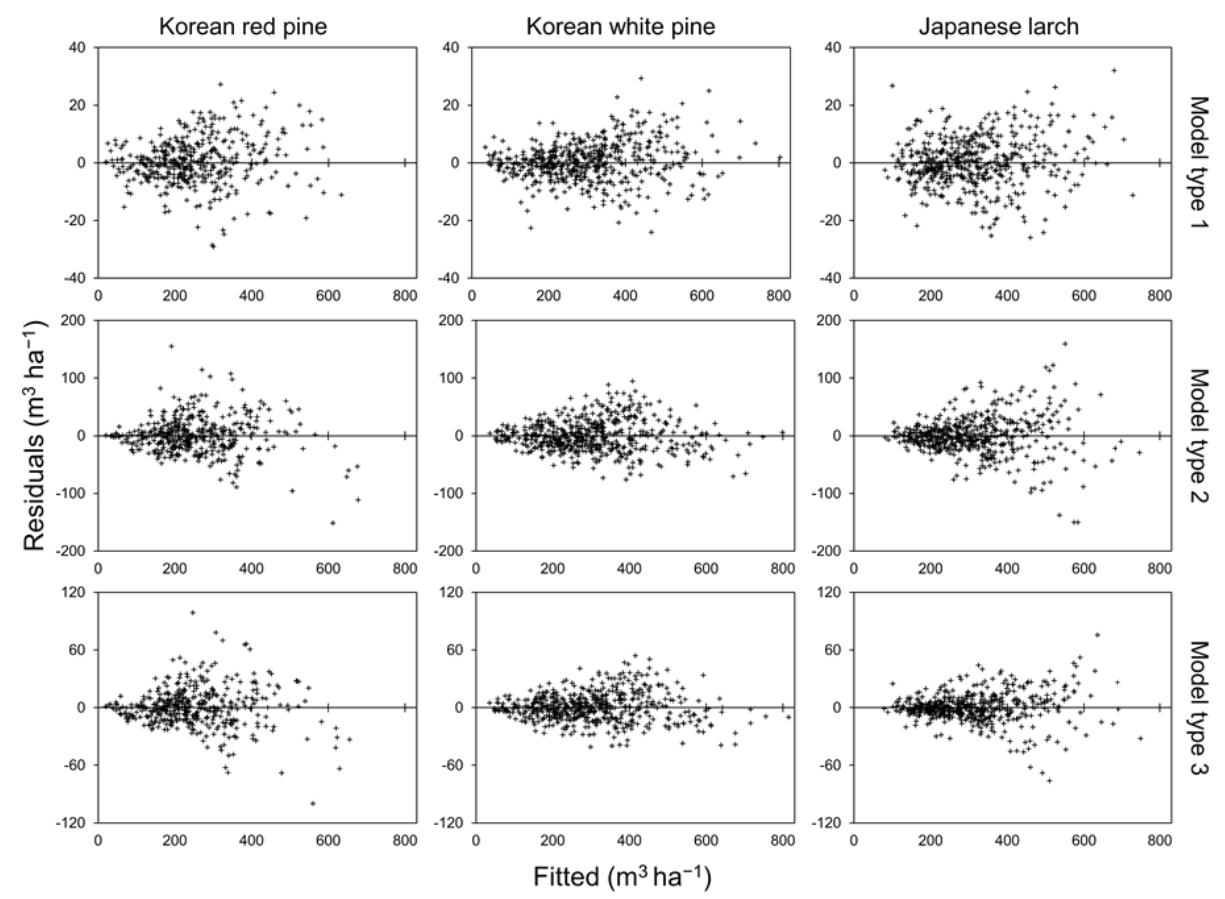
Figure 2. Residual plots of the variable-density yield models, with an arithmetic scale over the fitted values by species and model type. The fitted values were derived from the mixed-effect parameters in Table 4 using Equation (11).